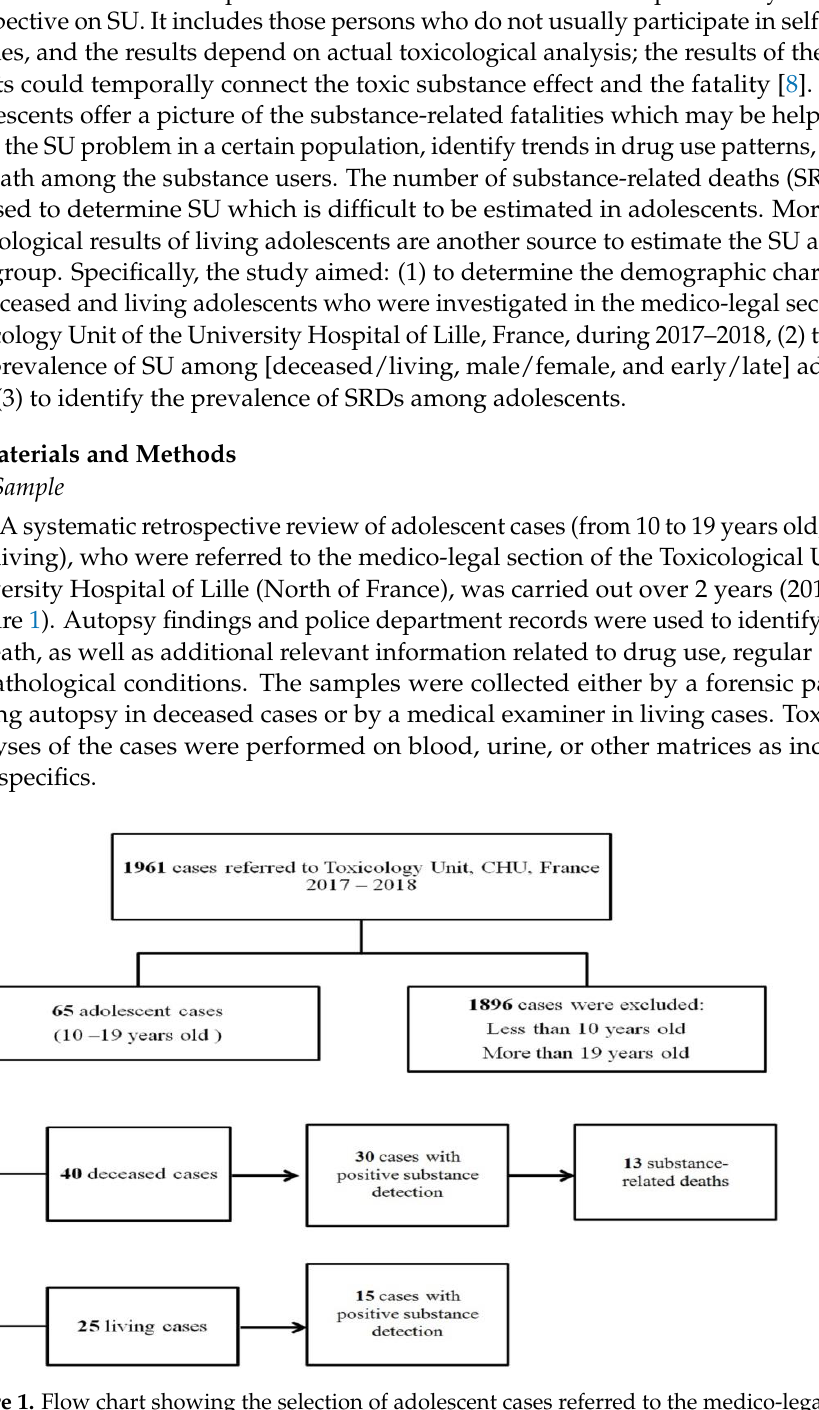
Figure 1. Flow chart showing the selection of adolescent cases referred to the medico-legal section of the Toxicology Unit, University Hospital of Lille (North of France) during 2017 – 2018.